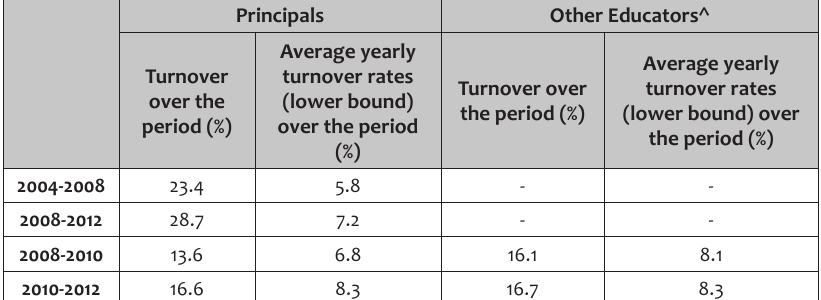
Table 2: Turnover rates for principals and other educators Principals Other Educators^ Average yearly Average yearly Turnover turnover rates Turnover over turnover rates over the (lower bound) the period (%) (lower bound) over period (%) over the period the period (%)